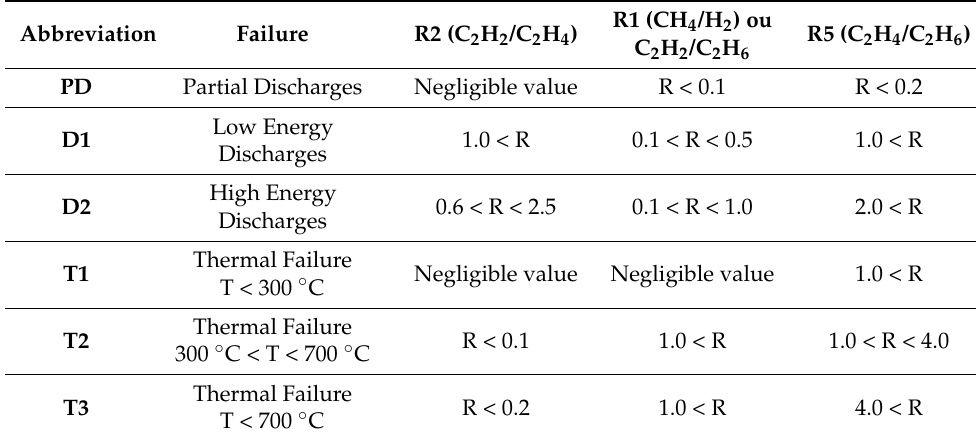
Table 4. IEC method—Failures and the correspondent ratio limits (adapted from